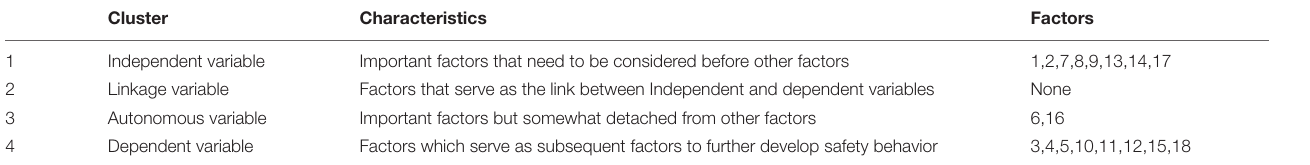
FIGURE 2 | Clusters of variables for safety behavioral model. TABLE 5 | Characteristics of safety behavior